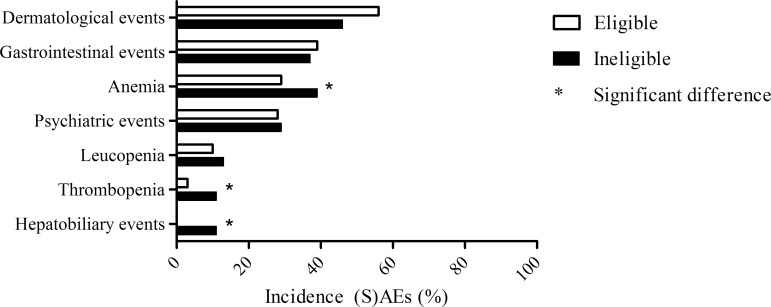
Incidence of specific (serious) adverse events in eligible and ineligible patients.The bars represent the incidence of various categories of (serious) adverse events between patients eligible and ineligible for registration trials. The asterix (*) marks significant differences between eligible and ineligible patients.